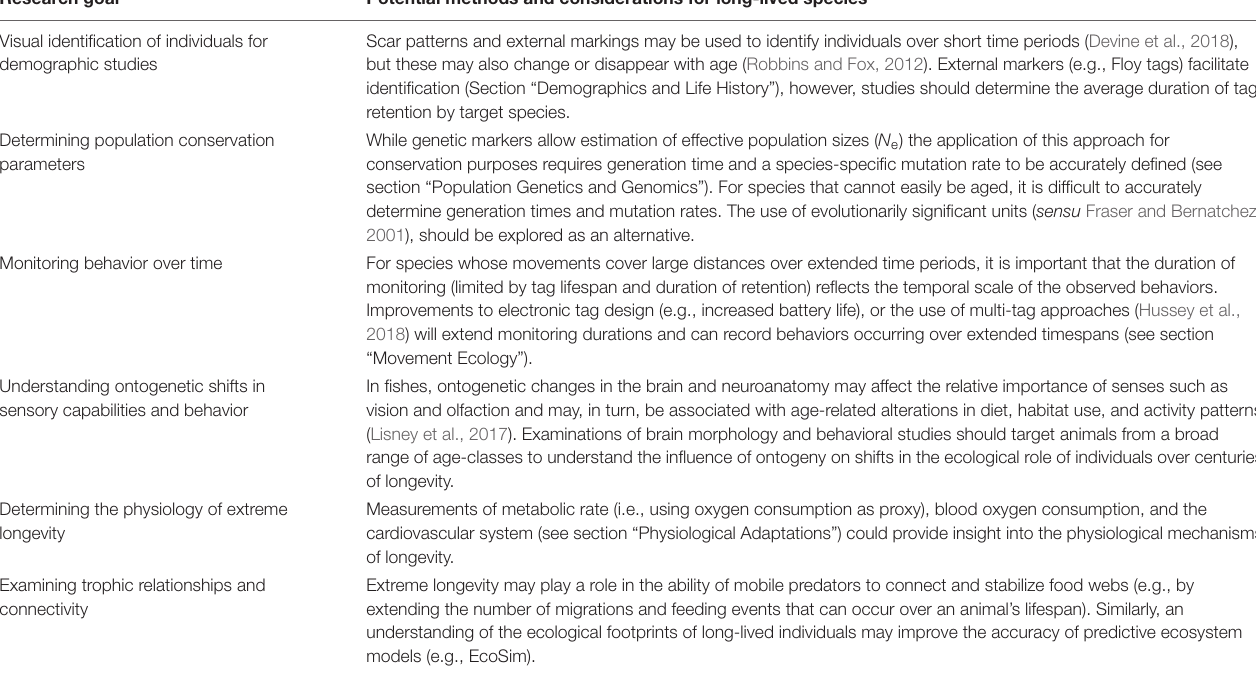
TABLE 2 | Research goals and considerations for advancing the study of long-lived